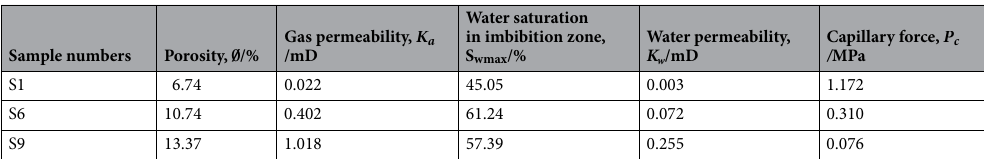
Table 3. Water permeability and capillary force of